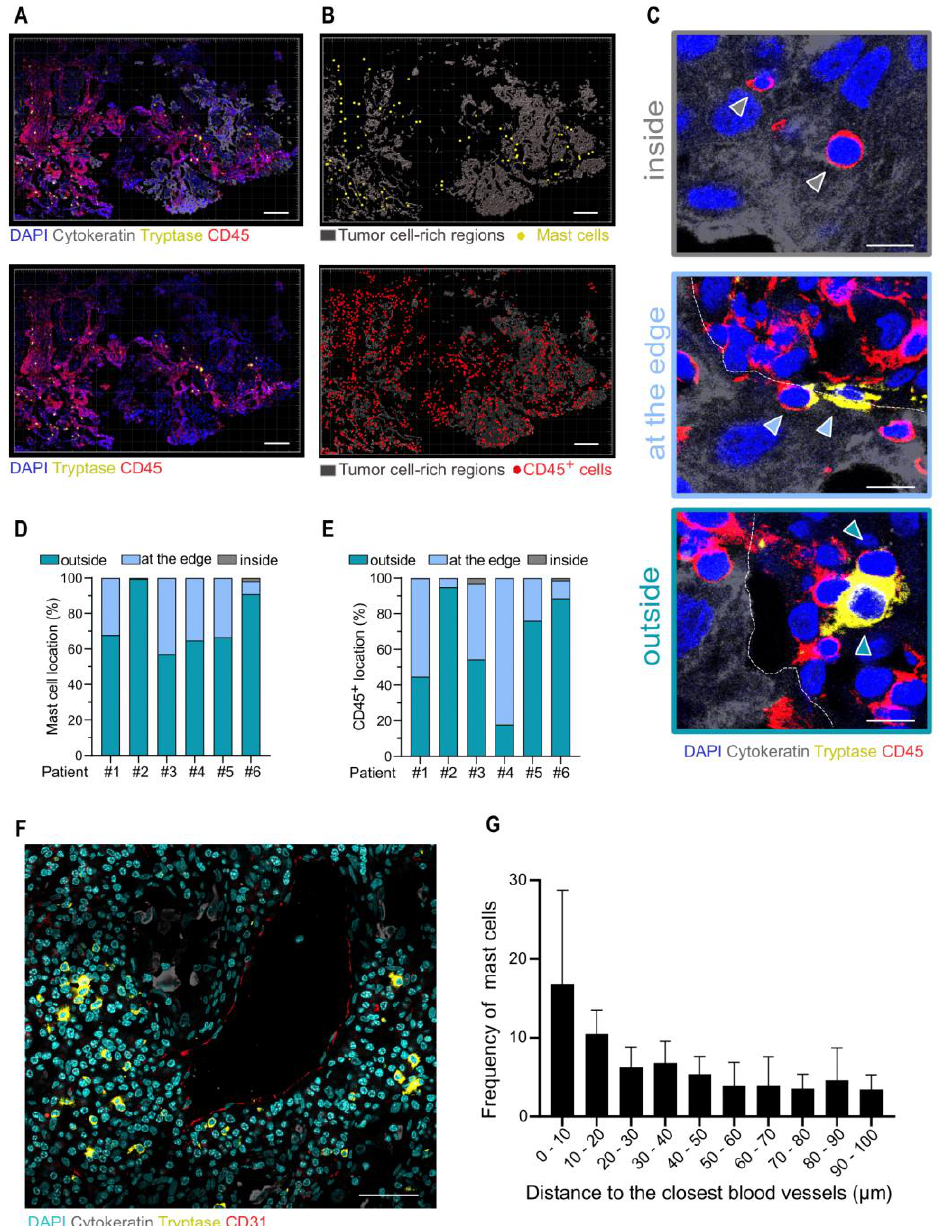
Figure 2. Mast cell cartography in NSCLC tumors. ( A ) Representative confocal large tile scan images of tumoral lung tissue section stained for Cytokeratin (grey), Tryptase (Yellow), and CD45 (red); Scale bar, 200 µ m. ( B ) Tryptase+ MCs (yellow) and CD45+ cells (red) were identified using Imaris software; Scale, 200 µ m. ( C ) Representative examples showing immune cells inside cytokeratin-rich regions (top), at the edge of the cytokeratin-rich regions (middle) or outside cytokeratin-rich regions (bottom). Arrows indicate examples of immune cells classified in the presented categories. Dashed lines indicate the cytokeratin-rich region edge. Scale bar, 10 µ m. ( D , E ) Frequency of MCs ( D ) and CD45+ cells ( E ) in the indicated categories ( n = 6 NSCLC patients). ( F ) Representative image showing MCs (Tryptase+, yellow), endothelial cells (CD31+, red), cancer cells (pan-cytokeratin+, grey), and nucleus (DAPI, cyan) in the TME. Scale bar = 50 µ m. ( G ) MC distribution according to their shortest distance to blood vessels. Results are from four patients. Bars represent mean and